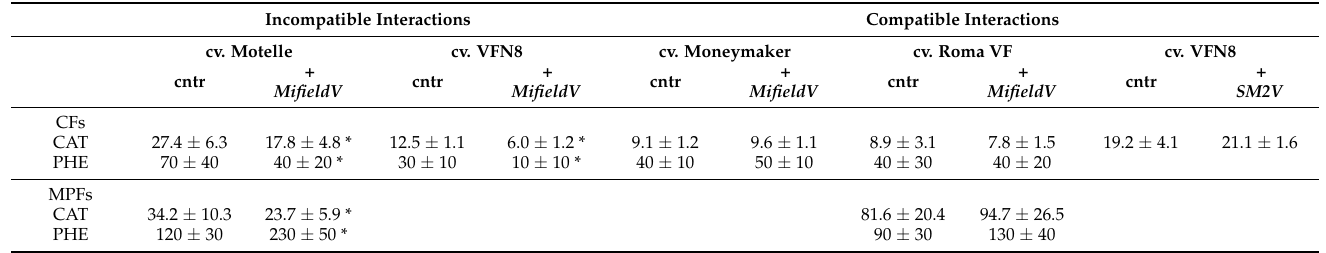
Figure 2. SOD, CAT, and APX activities in root crude extracts from control and resistant plants inoculated with MifieldV . Crude extracts were collected from plants harvested 1 and 2 days after inoculation (dpi). Means of enzyme activities are expressed as Units × mg − 1 prot ± standard deviation (SD) and separated by a paired t -test (* p < 0.01). Table 1. Catalase activity (CAT, units/mg prot) and phenol content (PHE, µ g/g rfw) in root cytosolic fractions (CFs) and mitochondrial/peroxisomal fractions (MPFs). Resistant (cvsMotelle and VFN8) and susceptible (cvs Moneymaker and Roma VF) tomato plants were inoculated with a M. incognita avirulent population ( MifieldV ) or left not inoculated as a control (cntr). Motelle cv. was inoculated also with a lab-selected M. incognita virulent population ( SM2V ) to have another compatible interac- tion. Data from incompatible and compatible RKN–tomato interactions were determined at 5 dpi. Values are expressed as means ( n = 9) ± SD. Asterisks indicate significant difference with respect to controls according to a paired t -test ( p <